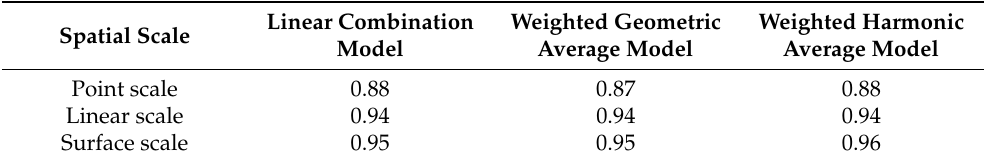
Table 3. Determination coefficients (R 2 ) of the modified slope deformation prediction model at different spatial scales with 200 grids.